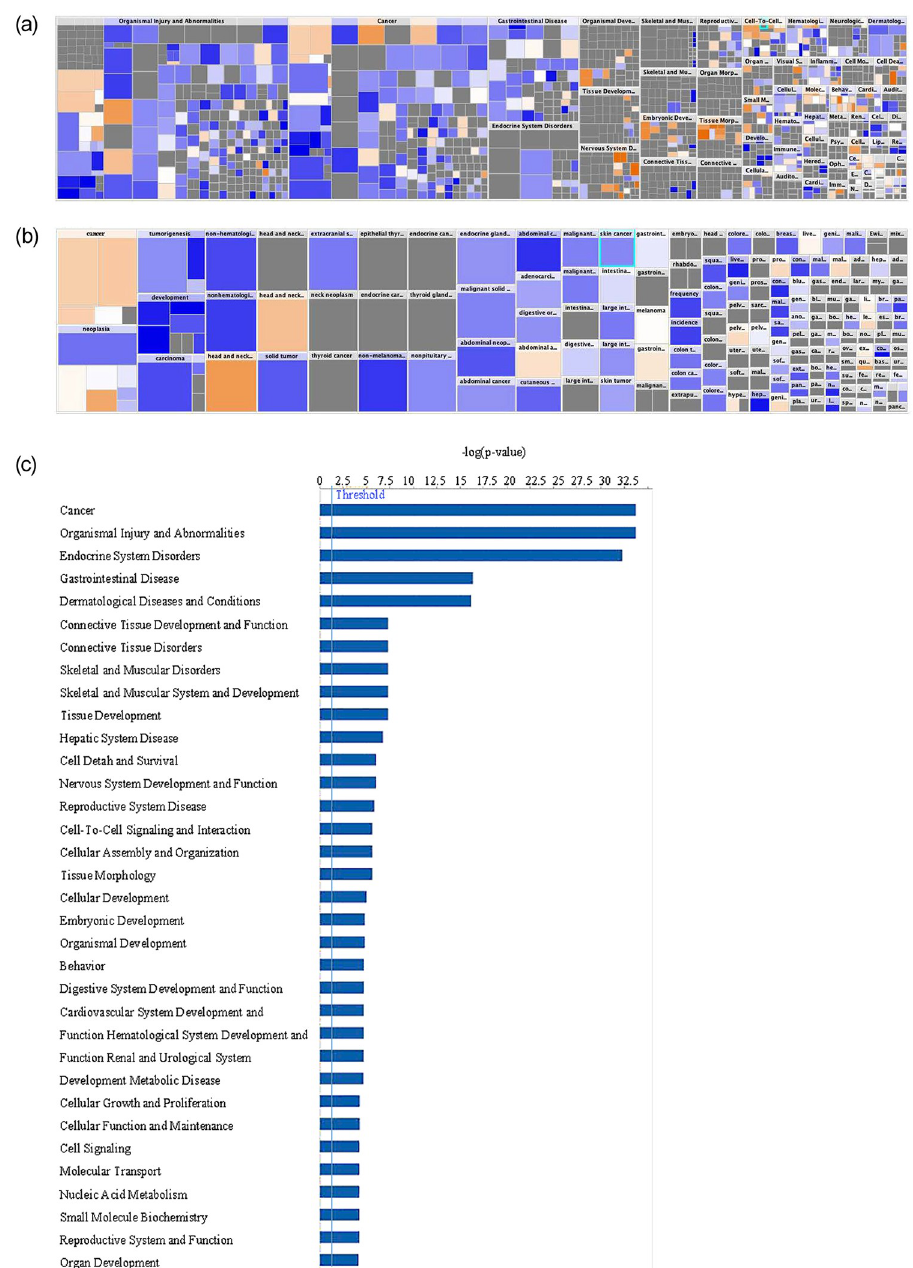
Fig 5. Gene network analysis between DACH1 mutated and wild-type patients. (A) A heatmap of the network analysis of genes differentially expressed between DACH1 mutated patients and wild-type by organ and disease system pathways is shown. The size of the box denotes the -log(p-value). The color of the boxes correlates with the z-score with the intensity of blue representing z � 0 and orange z � 0. Those with the highest z-scores and the greatest p- values include head and neck cancer, head and neck tumor, cancer of secretory structure, and neoplasia of cells. (B) Heatmap of network analysis separated by cancer disease process is shown. This shows an increased z-score in secretory cancers (-log[p-value] = 31.281, z-score = 0.547), head and neck cancers (-log[p-value] = 33.233, z- score = 1.463), abdominal adenocarcinoma (-log[p-value] = 16.306, z-score = 0.328), pelvic cancer (-log[p-value] = 5.439, z-score = 0.391), hyperplasia of the intestinal tract (-log[p-value] = 2.818, z-score = 0.239), prostate cancer (-log [p-value] = 4.883, z-score = 0.291), genital cancer (-log[p-value] = 3.967, z-score = 0.391), and quantity of malignant tumor (-log[p-value] = 2.502, z-score = 1.254). (C) Disease system pathways involved with DACH1 mutations are shown through network analysis of genes differentially expressed between DACH1 mutated patients and wild-type.